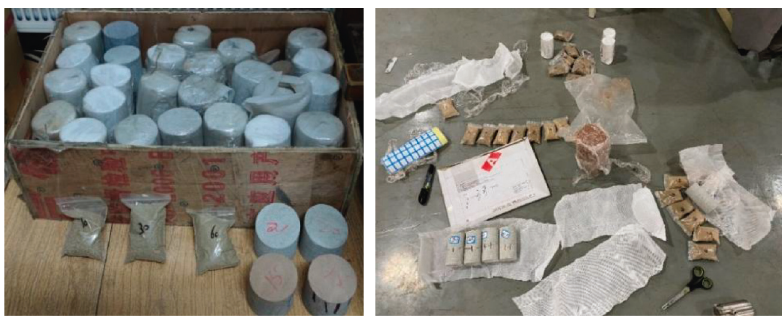
Figure 2: Specimen and sand with different particle